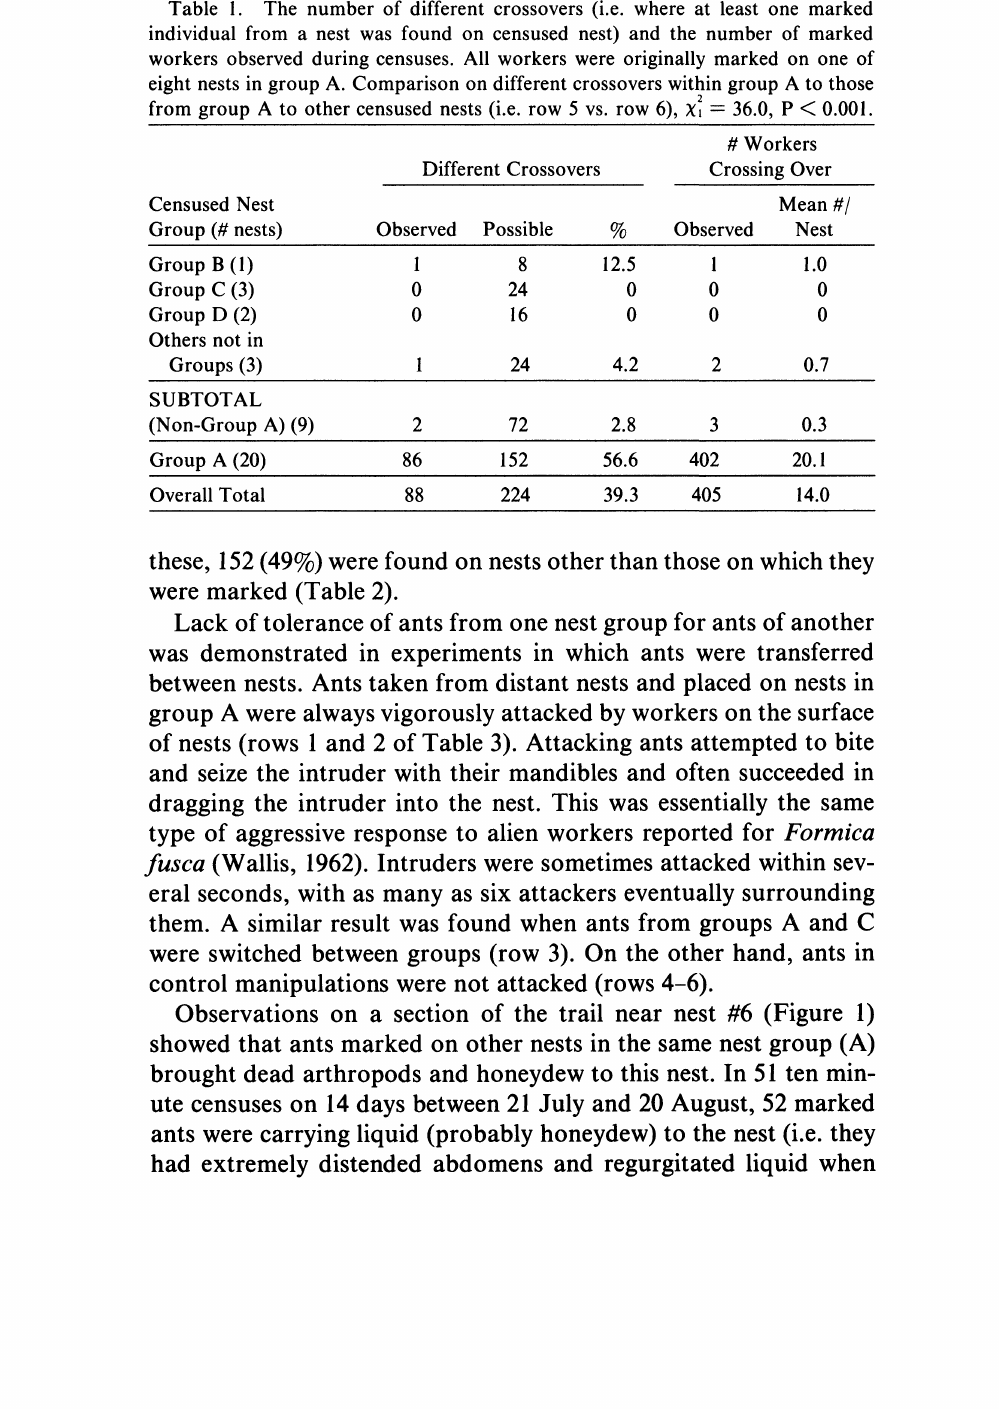
Table 1. The number of different crossovers (i.e. where at least one marked individual from a nest was found on censused nest) and the number of marked workers observed during censuses. All workers were originally marked on one of eight nests in group A. Comparison on different crossovers within group A to those from group A to other censused nests (i.e. row 5 vs. row 6), X 36.0, P < 0.001. # Workers Different Crossovers Crossing